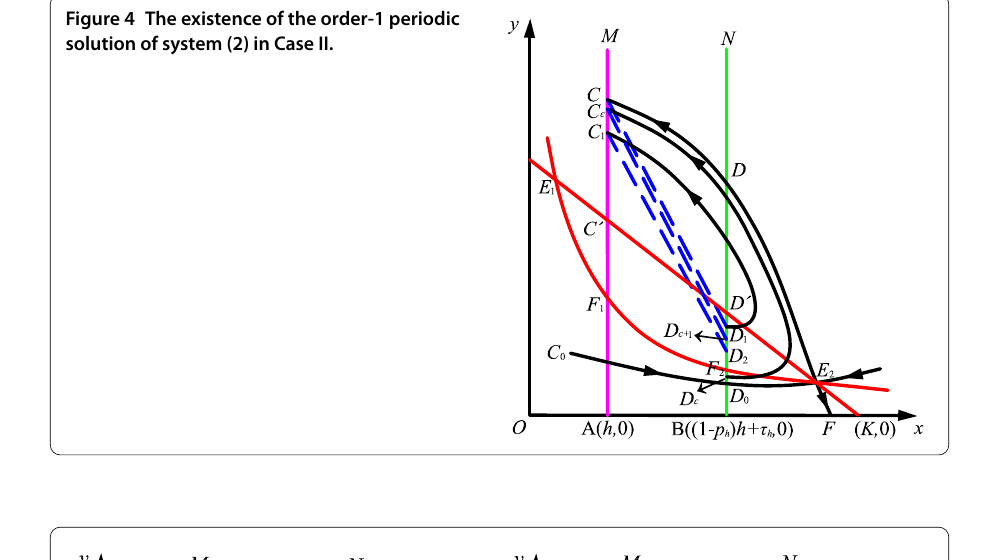
Figure 4 The existence of the order-1 periodic solution of system (2) in Case II.